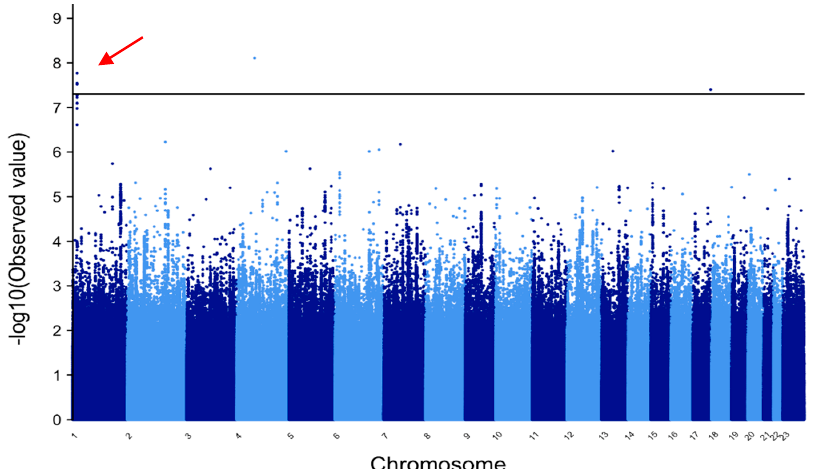
Figure 2. METAL Manhattan plot for generalized epilepsy European ancestry. Manhattan plots for the METAL analysis of generalized epilepsy patients of European ancestry. Multiple linked markers in the PADI4-6 locus reached genome-wide statistical significance for patients of European ancestry. No markers reached genome-wide significance in patients of African ancestry (plot not shown).